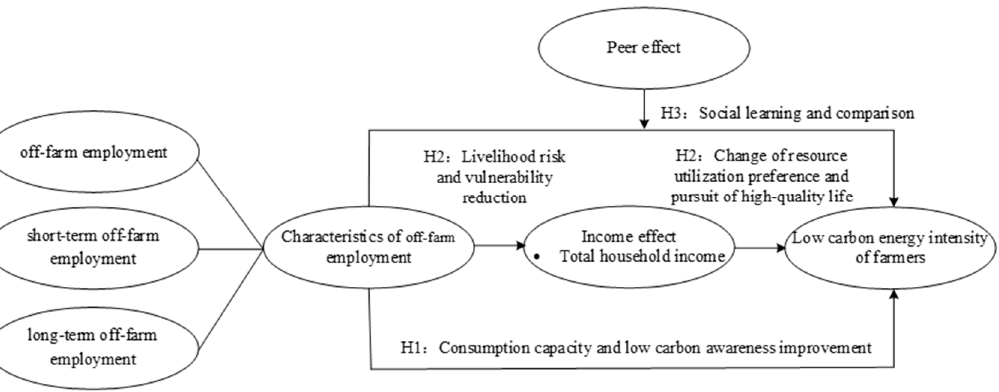
Figure 1. Mechanism of impact of off-farm employment on household low-carbon energy inten-